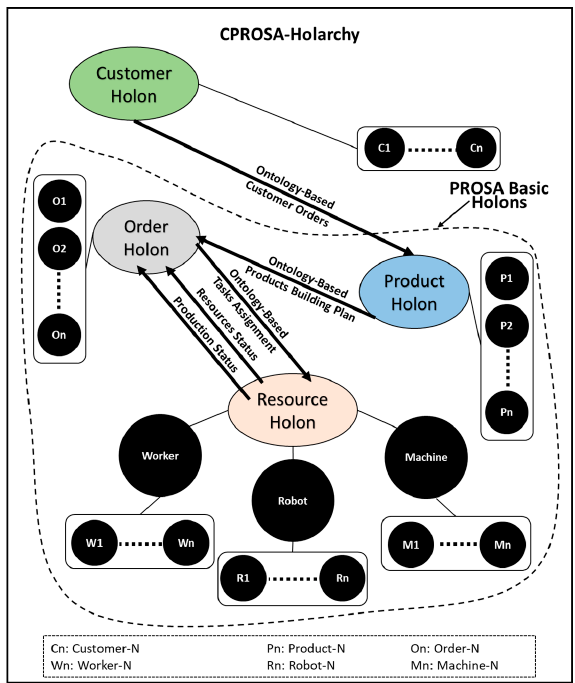
Figure 8. Proposed Holonic Control Architecture Model.